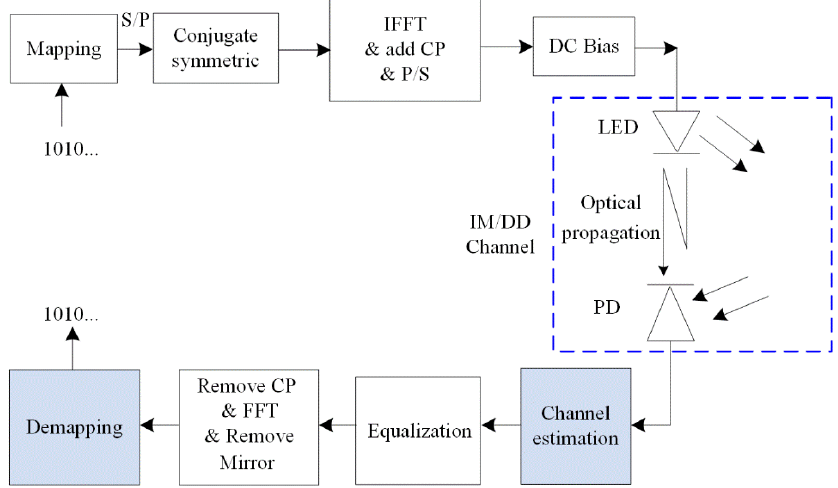
Figure 1. Block diagram of the DCO-OFDM system with an IM/DD channel.